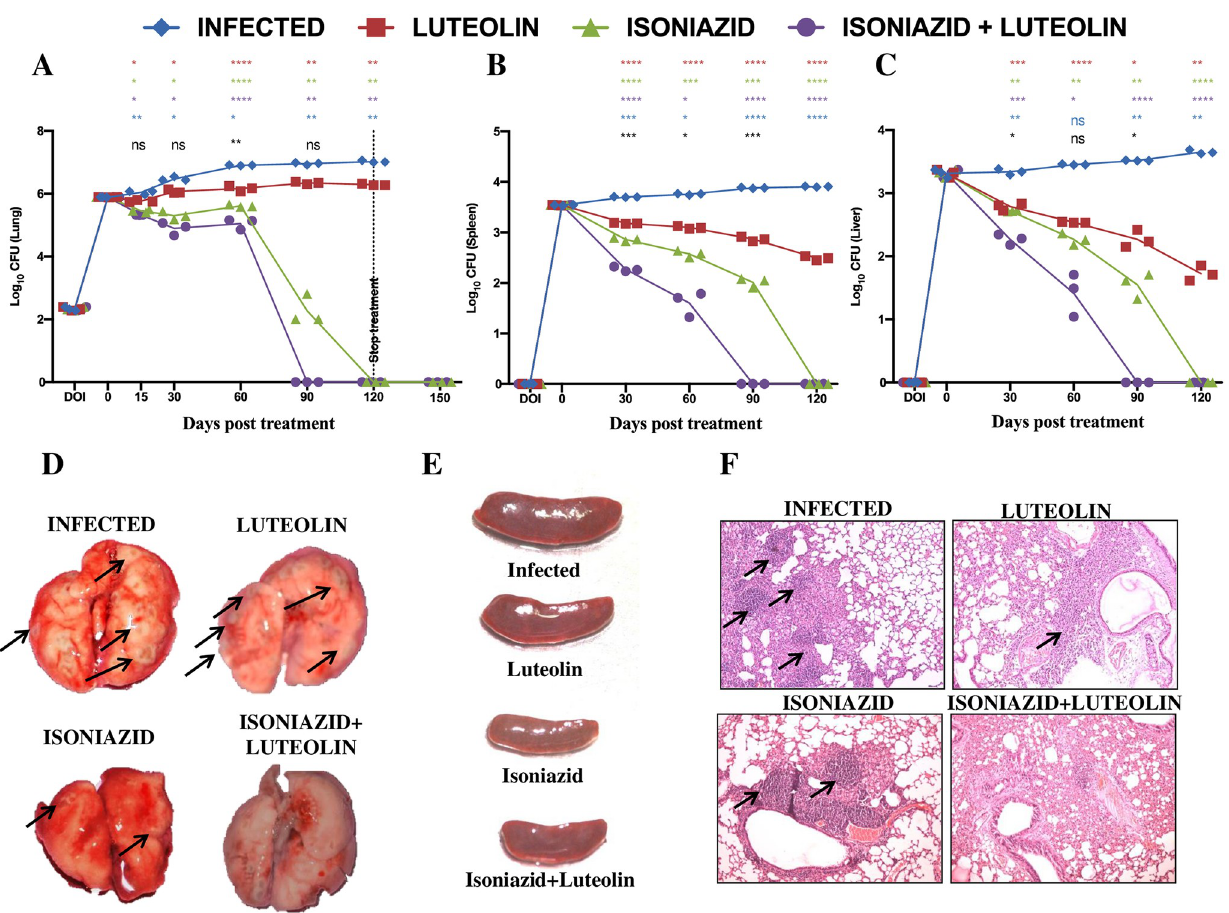
Fig 1. Luteolin protects mice against tuberculosis. C57BL/6 mice were challenged with H37Rv via the aerosol route with a dose inoculum of ~ 220 CFU/ mice, sacrificed at various time points and lungs and spleens were harvested. Log10 CFU from the lung (A) , spleen (B) and liver (C) homogenates of mice infected with H37Rv and treated with Luteolin, Isoniazid (INH) or Luteolin+INH. Data shown are representative of three independent experiments with three mice per group. Differences were considered significant at p < 0.05 and are represented as following: � for Infected vs. Luteolin, � for Infected vs. INH, � for Infected vs. Luteolin+INH, � for Luteolin vs. Luteolin+INH & � for INH vs. Luteolin+INH; � p < 0.05, �� p < 0.01, ��� p < 0.001, ���� p < 0.0001. Gross pathology of lungs (D) and spleen (E) at 60 dpi. Granuloma-like structures are indicated by arrows. (F) Lungs were dissected out and preserved in 4% paraformaldehyde. These preserved lungs were then processed for paraffin embedding, sectioning and staining with Hematoxylin and Eosin (H&E). Granuloma-like structures are indicated by arrows.